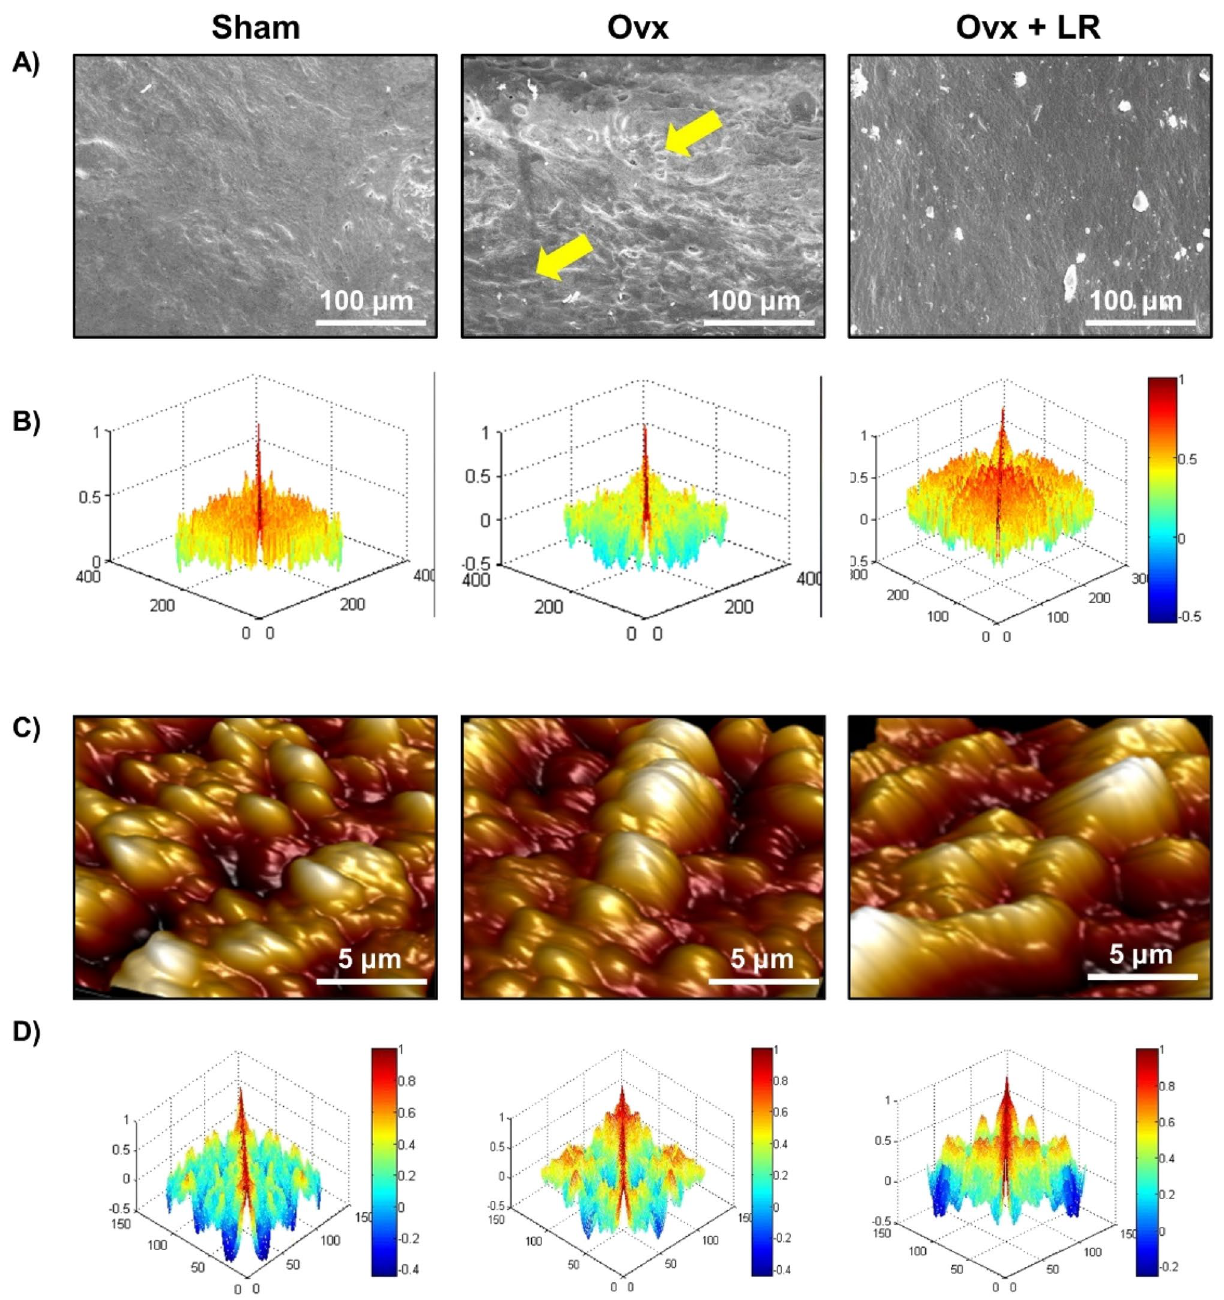
Figure 4. LR attenuates bone loss in Ovx mice. Mice were sacrificed at the end of experiment and cortical bones of all groups were collected for SEM and AFM analysis. ( A ) 2D SEM images. ( B ) 2D MATLAB analysis of SEM images. ( C ) 3D AFM images. ( D ) 2D MATLAB analysis of AFM image. The above images are indicative of one independent experiment and comparable results were obtained in two different independent experiments with n = 6